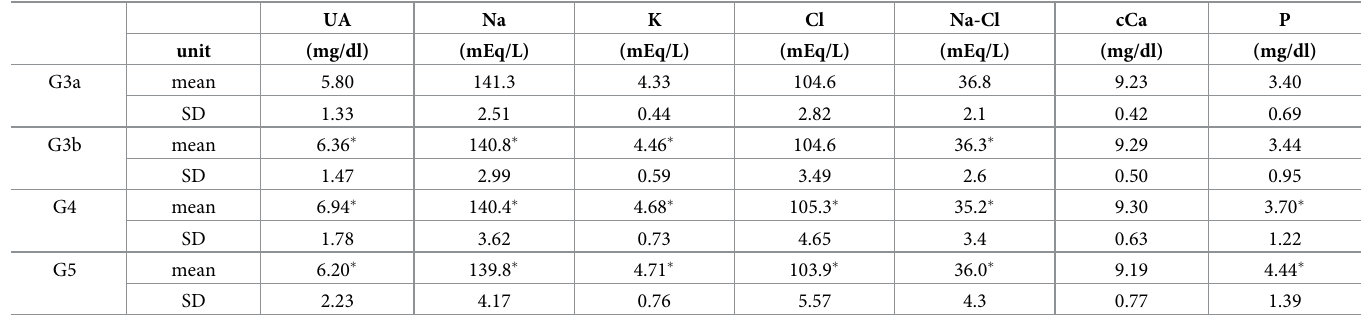
Table 3. Serum uric acid and electrolyte status stratification according to G category strata.